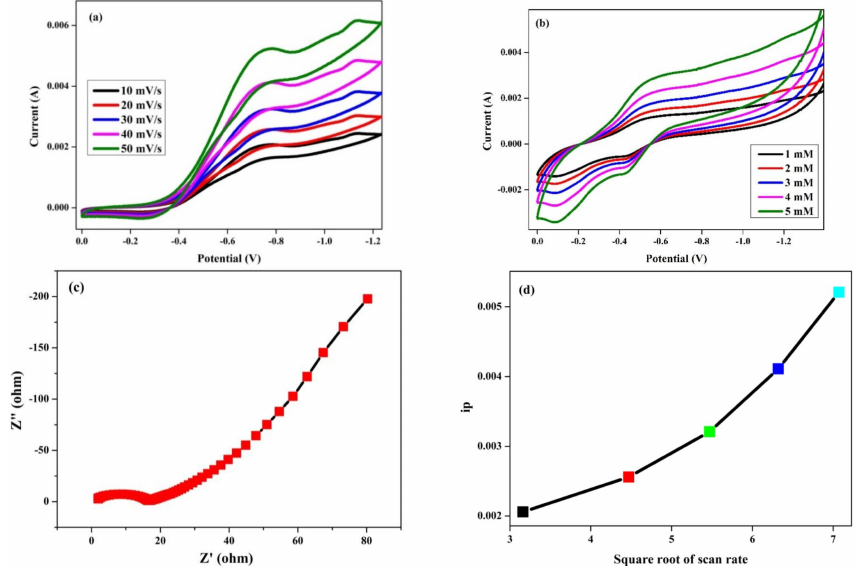
Figure 11. ( a ) CV graph of Cu-Zn-Mn mixed trimetal oxide nanoparticles with different scan rates, ( b ) CV graph with glucose at different concentrations, ( c ) Nyquist plots of the Cu-Zn-Mn mixed trimetal oxide, ( d ) plot of peak current vs. square root of scan